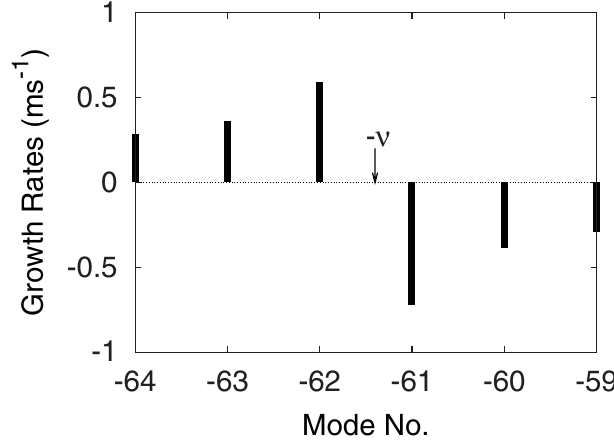
FIG. 8. The growth rates of some of the transverse, multibunch Fourier modes in the DCO2 damping ring, assuming uniform focusing, calculated using the analytic formula in [9]. The tune, (cid:12) , is